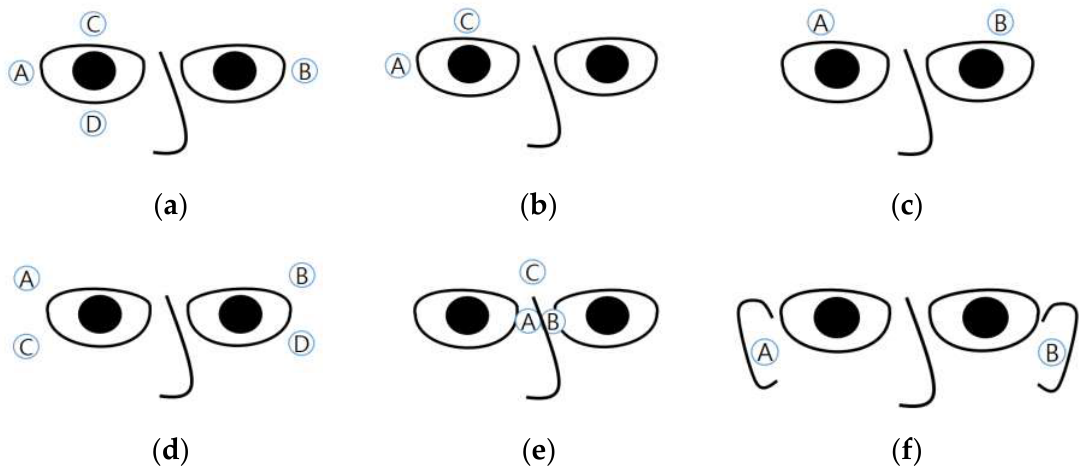
Figure 3. Six different electrode positions to measure EOGs in the literature. The letters A, B, C, and D indicated in circles denote the locations of